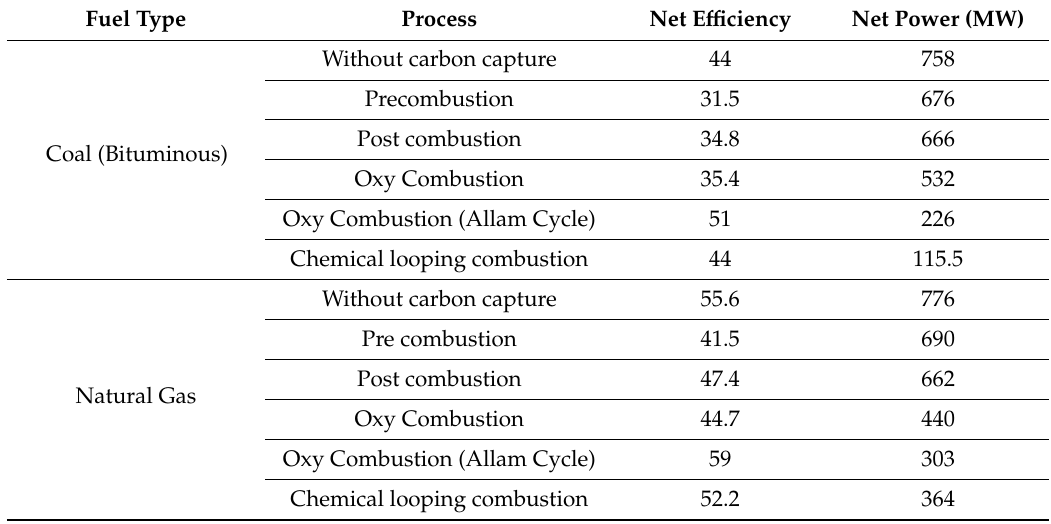
Table 6. E ffi ciency comparison of power generation with di ff erent carbon capture processes